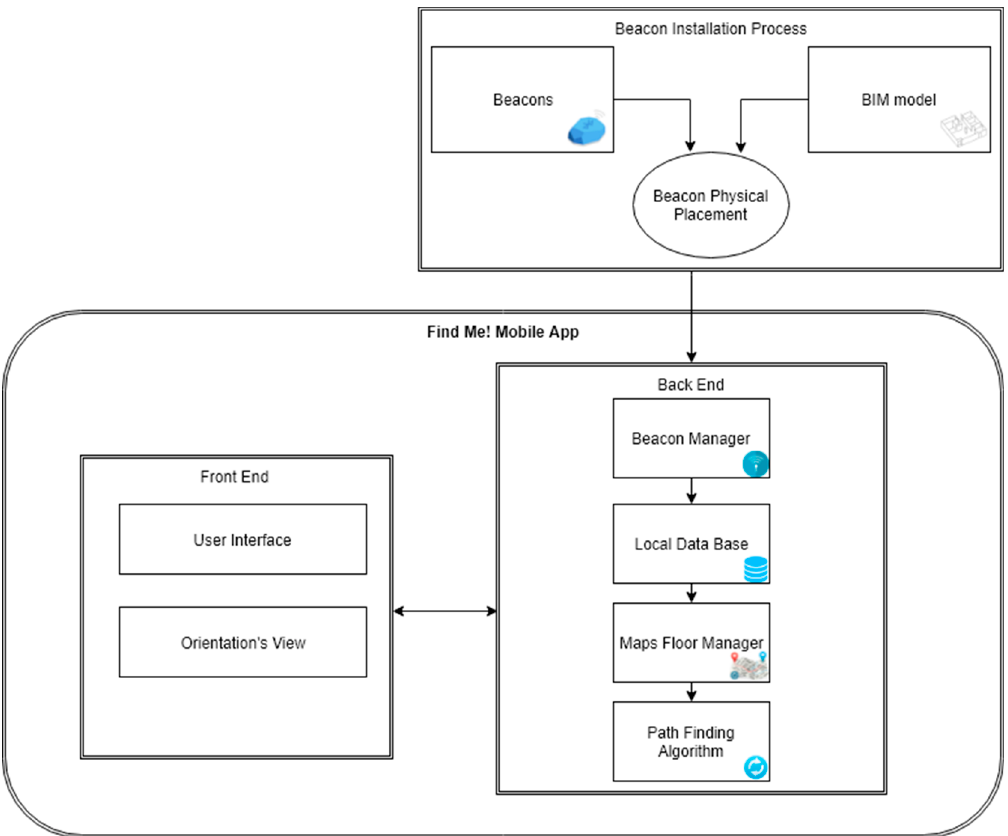
Figure 2. Find Me! architecture.